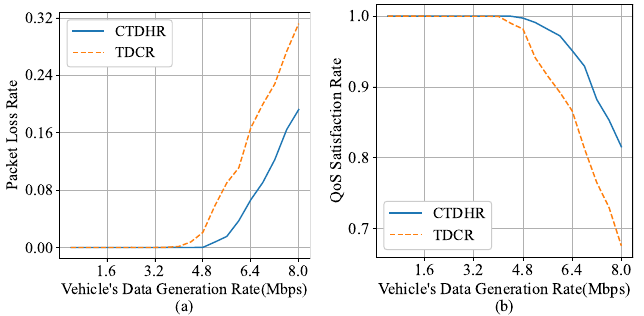
Figure 7. Comparison of CTDHR and TDCR in the communication performance. ( a ) The comparison of the packet loss rate, ( b ) the comparison of the QoS satisfaction